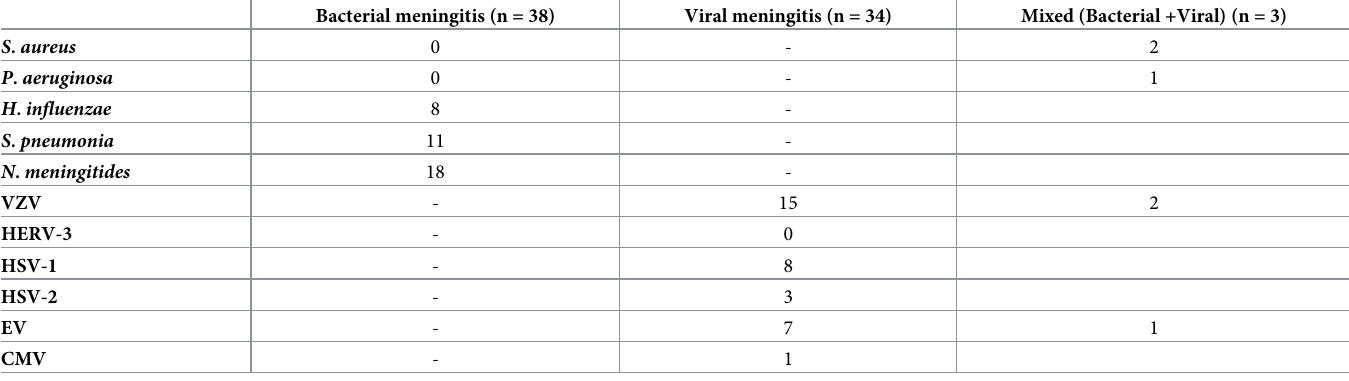
Table 3. Causative agents of meningitis in this study.